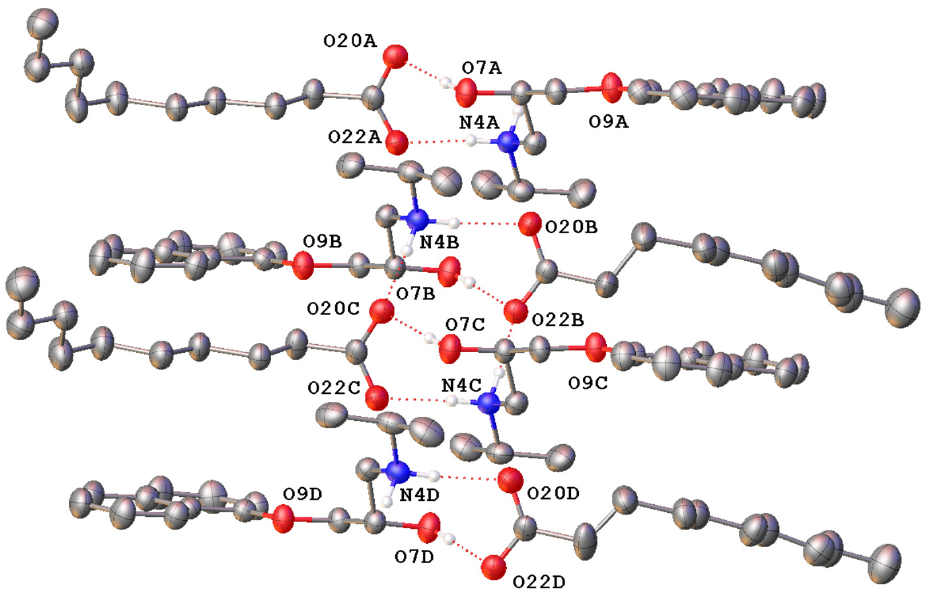
Figure 2. Molecular structure of the asymmetric unit of propranolol caprate (PRC) salt showing the four unique ion pairs with hydrogen bonding represented by dotted lines (only hydrogen atoms involved in hydrogen bonding shown). Only the majority occupied disordered caprate chain is shown (73% occupied). Heteroatoms labelled only, and atomic displacement shown at 50% proba- bility.